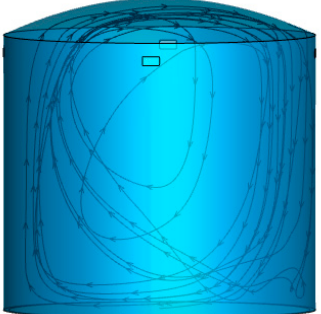
Figure 5. Streamtraces inside the tank for the floating-deck height of 2.82 m.